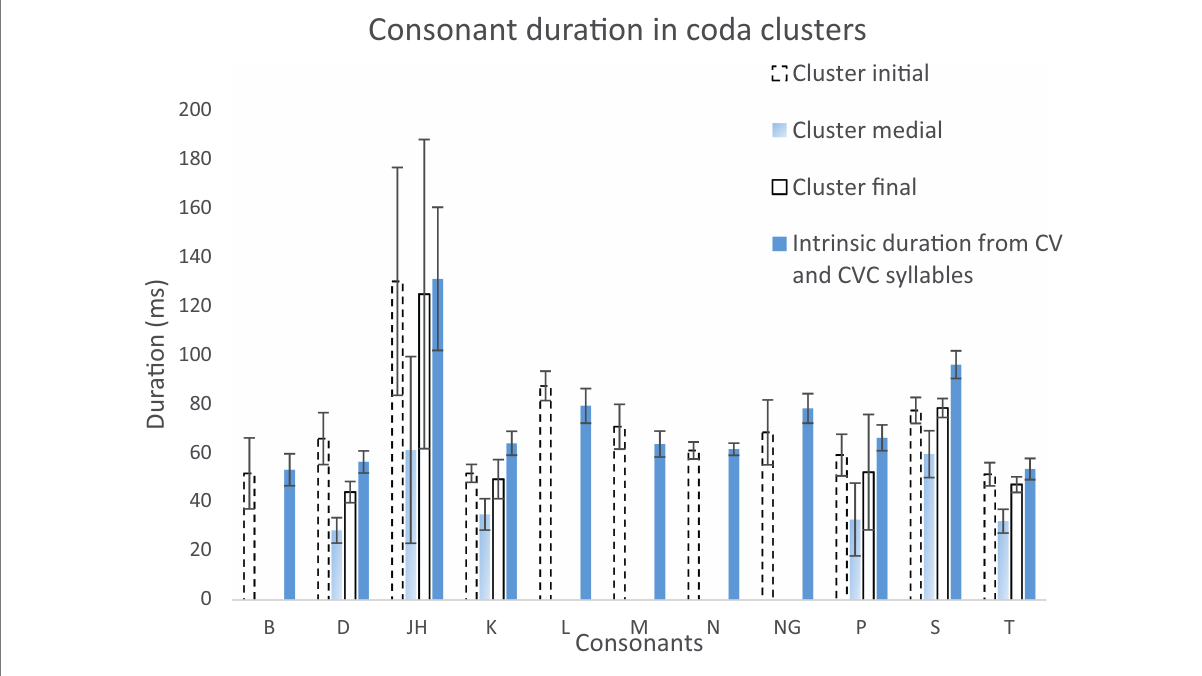
FIGURE 8 Consonant duration in initial, medial, final position in coda consonant clusters and intrinsic durations of the same consonants in coda, calculated from CVC syllables. CCCVCC, CCVCC, CCVCCC, CVCC, CVCCC syllables are pooled together here.